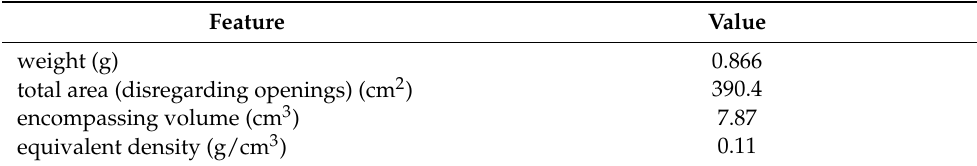
Figure 2. Photos of the printed, engineered object based on the design of frustule of Didymosphenia geminata before compression test: ( A , D ) valve view; ( B ) headpole ending; ( C ) footpole ending; ( E ) girdle band view with designations: 1 — length; 2 — width of the headpole, 3 — width in the middle part; 4 — width of the footpole; 5 — thickness in the headpole; 6 — thickness in the middle part; 7 — thickness in the footpole. Table 2. The weight/size characteristic of the 3D printed engineered object.